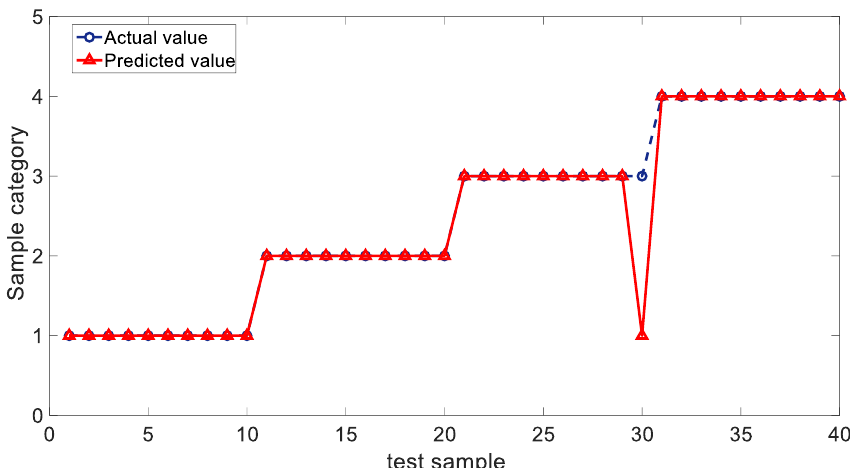
Figure 18. Comparison between the actual and predicted values by GA_BP_NN.